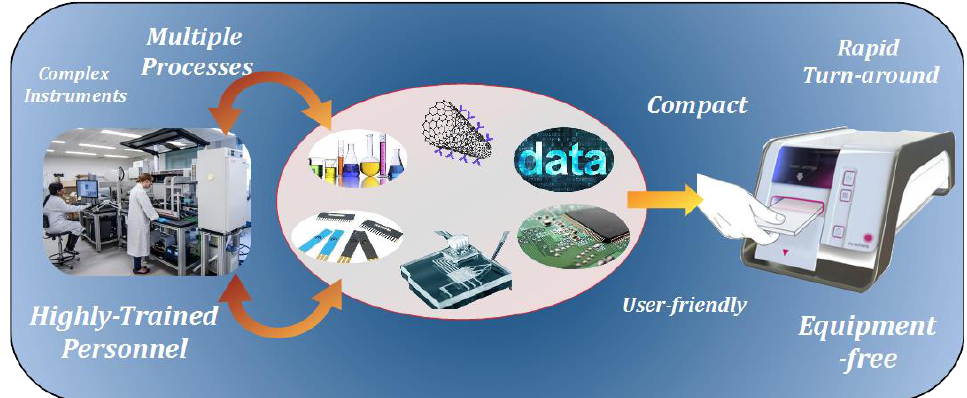
Figure 6. Transitioning from laboratory assays to cartridge-based POC platforms.